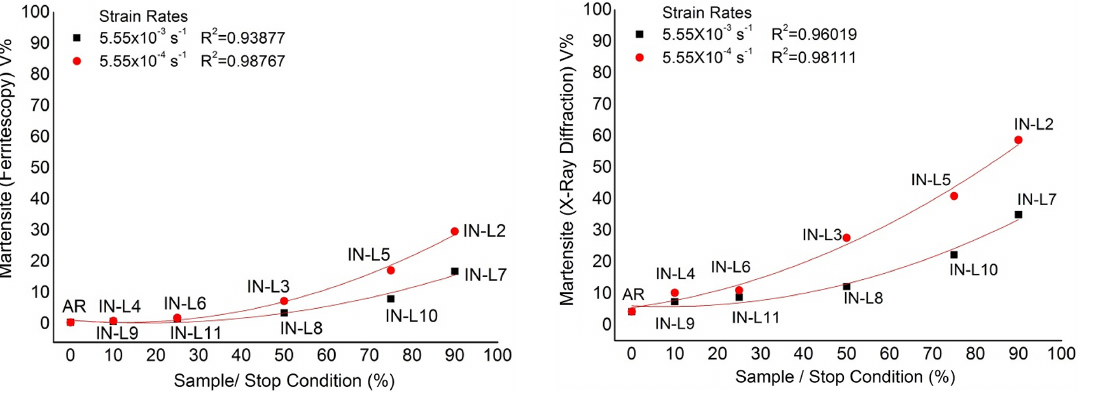
Figure 3. Volume fraction of deformation induced martensite in samples of the first group for two different strain rates, measured by X-ray diffraction. Samples with grinding/polishing..